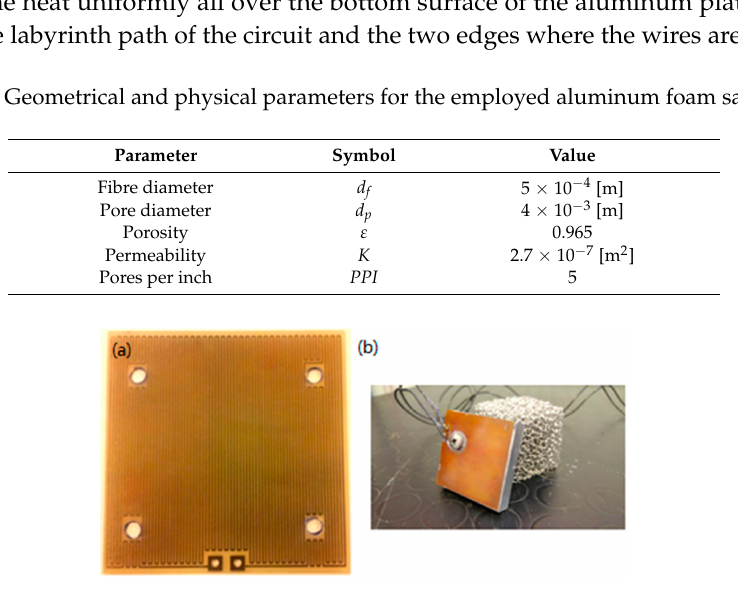
Figure 1. ( a ) Custom-made heater; ( b ) heater in contact with the aluminum